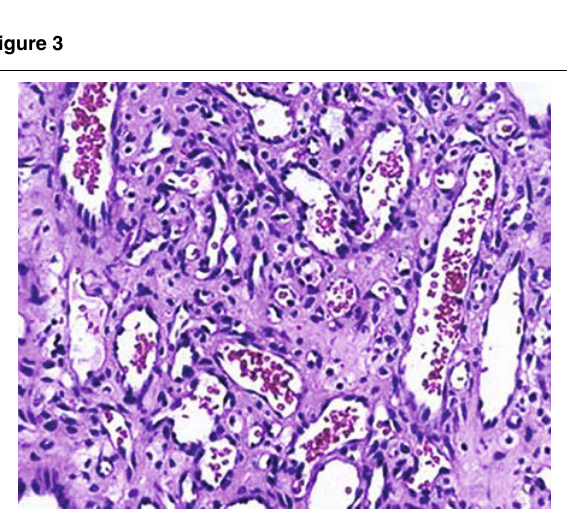
Photomicrograph of hematoxylin and eosin (×200) stained sample of a nasal mass shows thin-walled small-and medium-sized capillaries lined by a single layer of endothelium with intervening (cid:383) brous stroma.